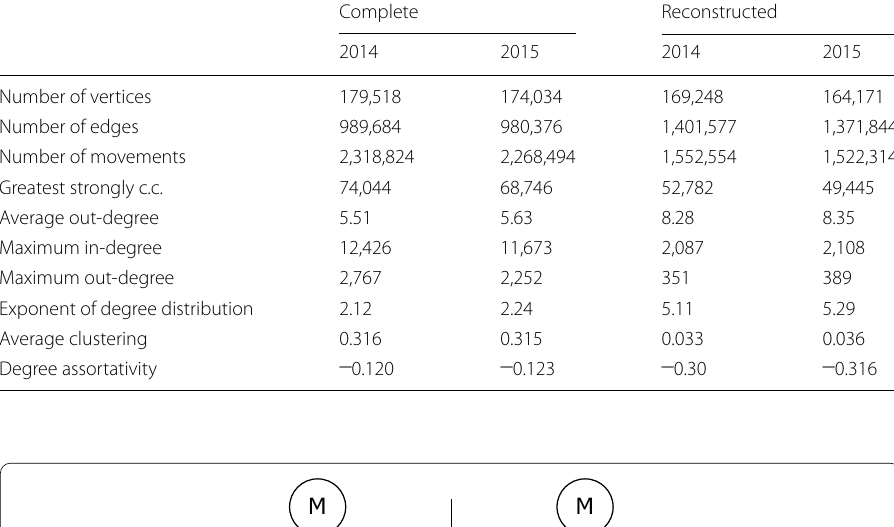
Table 1 Summary statistics of the French cattle trade networks, aggregated over a year Complete